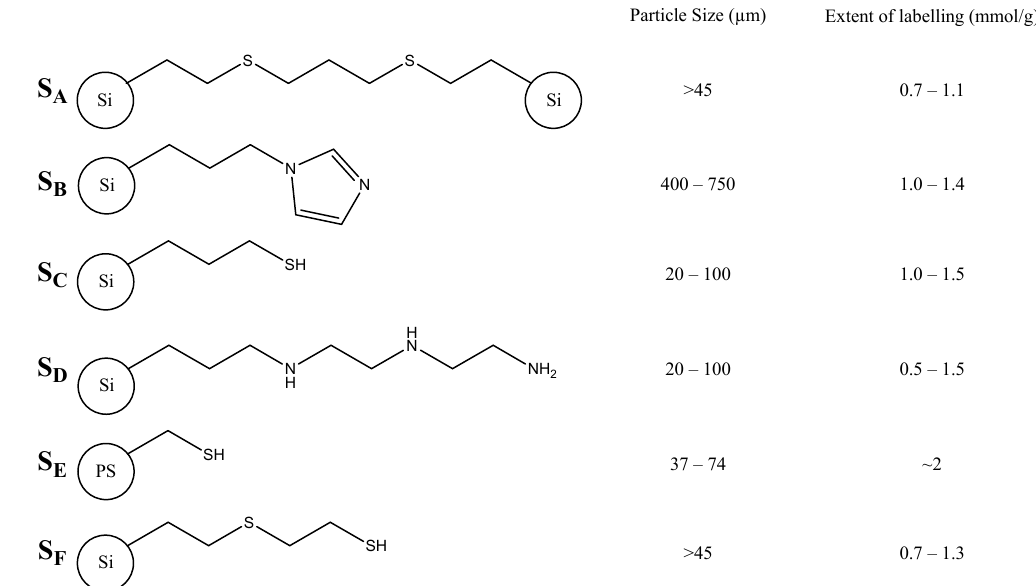
Figure 1. Scavengers tested by Barskiy et al. [ 46] S A – S F are silica mounted except S E which is polystyrene (PS) mounted.